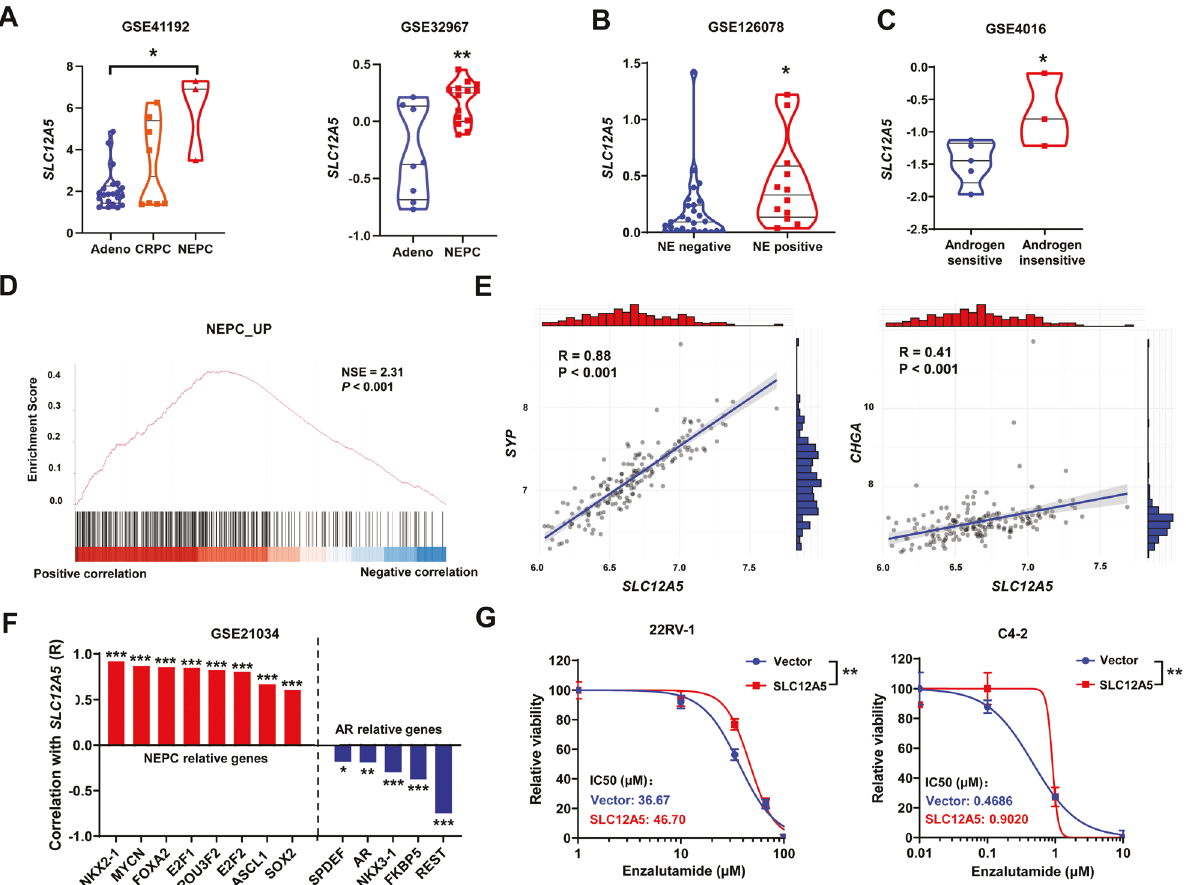
Fig. 3 The role of SLC12A5 in castration resistance and neuroendocrine differentiation of prostate cancer. A SLC12A5 mRNA expression patterns in CRPC and NEPC tissues. B The expression levels of SLC12A5 in the NE positive tumor tissues and NE negative tissues in GSE126078 dataset. C The expression levels of SLC12A5 in androgen-insensitive prostate cancer cell lines and androgen-sensitive prostate cancer cell lines in GSE4016 dataset. D GSEA showed that SLC12A5 expression was positively correlated with genes that are upregulated in NEPC using GSE21034 dataset. E The correlations of SLC12A5 with NEPC markers (SYP and CHGA) in GSE21034 dataset. F The correlations of SLC12A5 with NEPC relative genes ( NKX2-1 , MYCN , FOXA2 , E2F1 , POU3F2 , E2F2 , ASCL1 , SOX2 ) and AR relative genes ( AR, SPDEF, NKX3-1, FKBP5, REST ) in GSE21034 dataset. G The effect of SLC12A5 overexpression on the enzalutamide resistance in 22RV-1 and C4-2 cells. IC50 curves and values were generated using Graphpad Prism 8.0. The differences in viability between two groups were evaluated using two-way analysis of variance (ANOVA). * P < 0.05; ** P < 0.01; *** P <